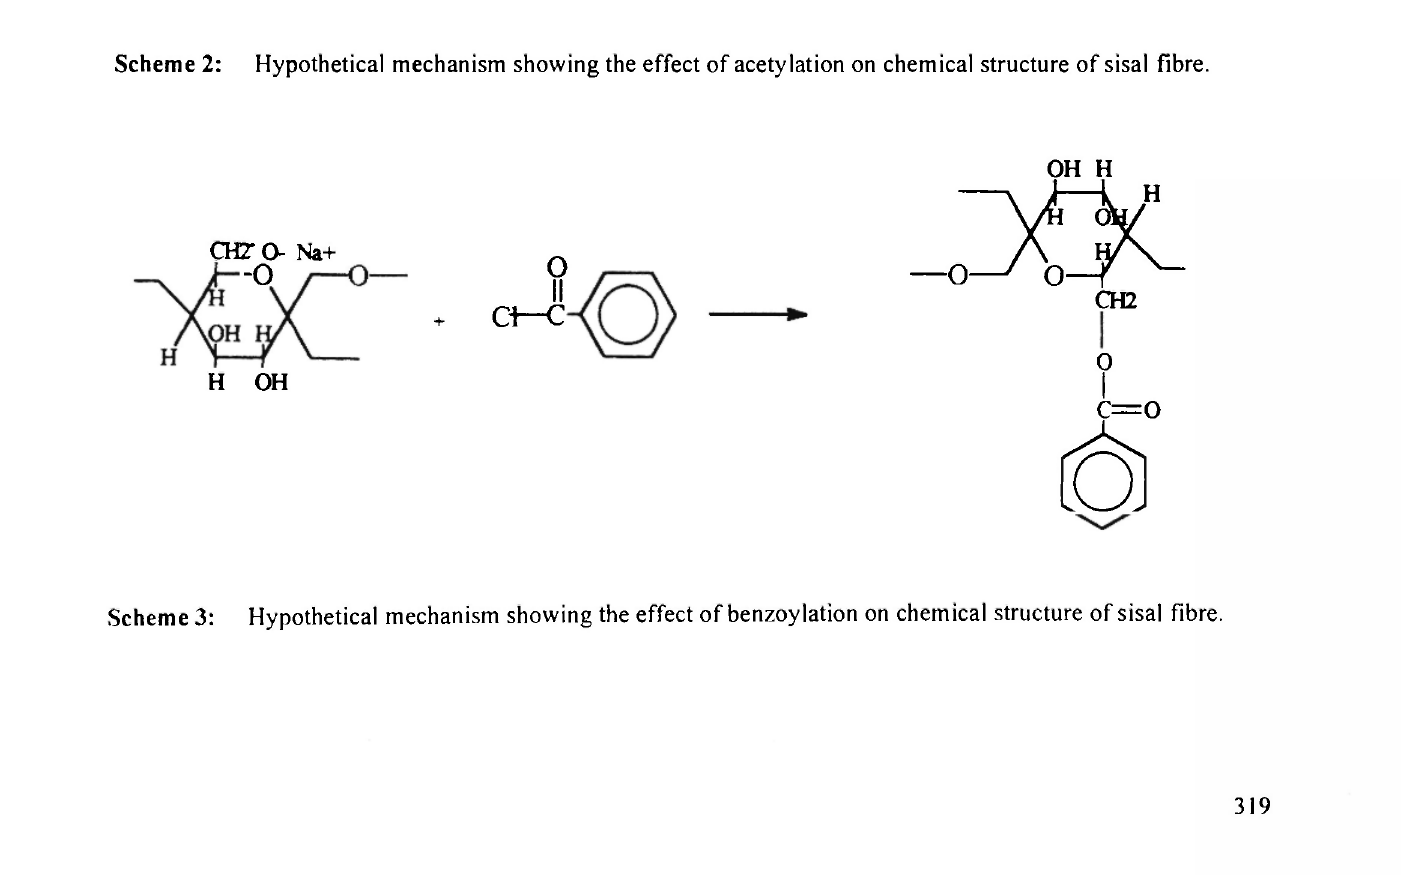
Hypothetical mechanism showing the effect of acetylation on chemical structure of sisal fibre.